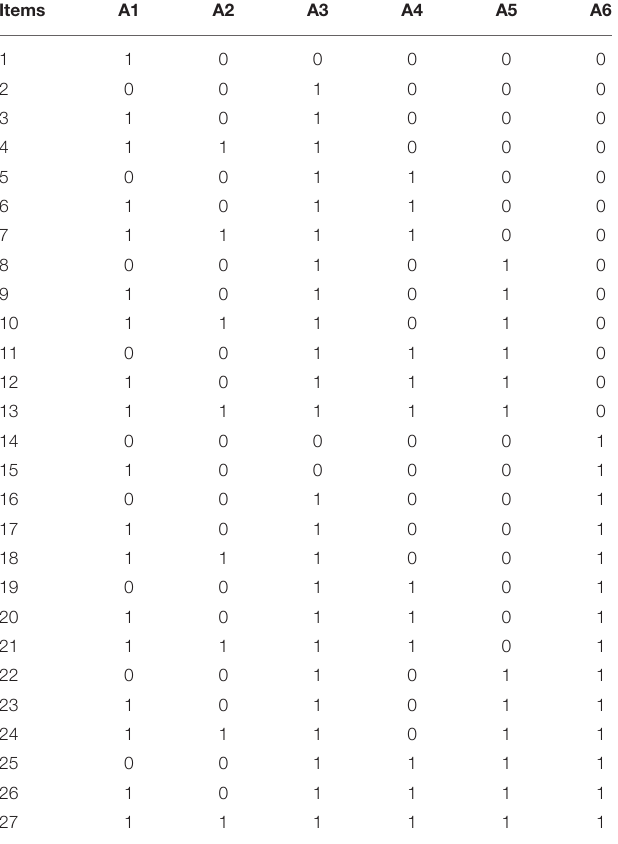
TABLE 1 | Initial Q-matrix. TABLE 2 | Final